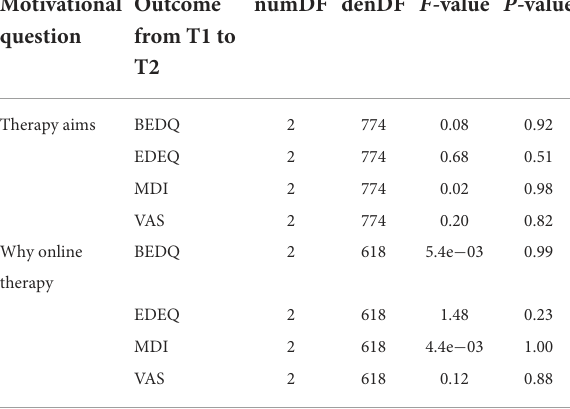
TABLE 8 Results of factorial ANOVA tests on the interaction between motivational types and various patient variables.